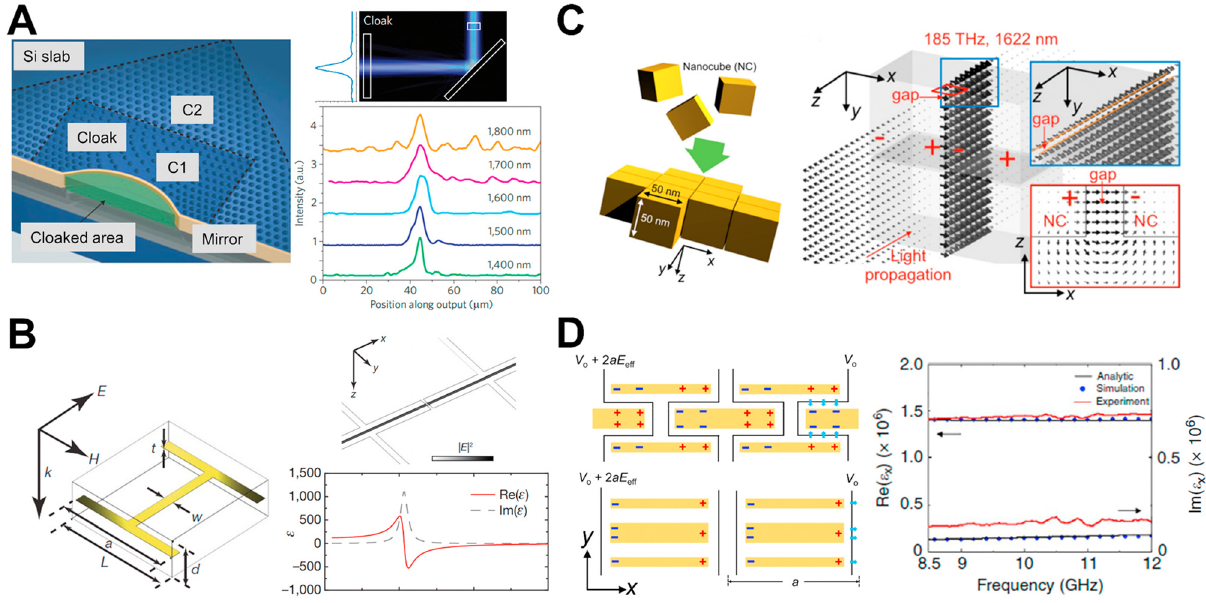
Figure 3: Metamaterials with near dispersion-less effective electric permittivity. (A) A schematic of a carpet cloak and its broadband cloak performance. Adapted with permission from Ref. [9]. Copyright 2009, Springer Nature. (B) A schematic diagram of small-gap I-shaped metamaterialwithbroadbandhighpermittivity(left).Thecapacitivecoupling(stronglocalelectric fi eldinthesmall-gapregion)istheoriginof the enhanced effective permittivity. Adapted with permission from Ref. [7]. Copyright 2011, Springer Nature. (C) A schematic of a metal- nanocube array and local electric fi eld distribution under light incidence, which shows enhanced permittivity at near-infrared frequency regime. Reproduced with permission [33]. Copyright 2015, Optical Society of America. (D) The principle of broadband polarization enhancementandmeasureddielectricconstants.AdaptedfromRef.[37].Copyright2016,TheAuthors.DistributedunderaCreativeCommons Attribution 4.0 International License (CC